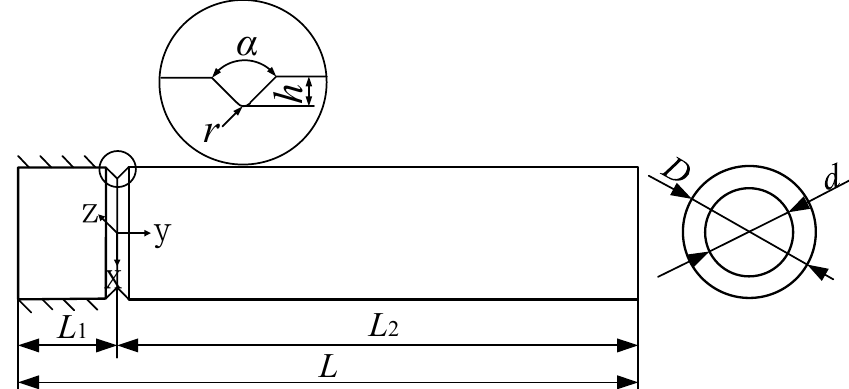
Figure 6. Tubing geometry parameters.